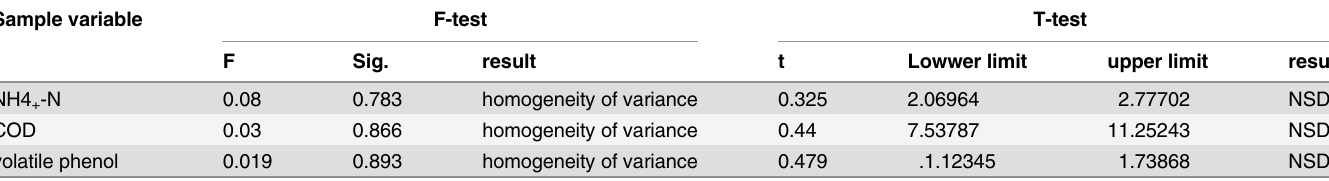
Table 6. The test on the result of water quality monitoring optimization in Taizi River. Sample